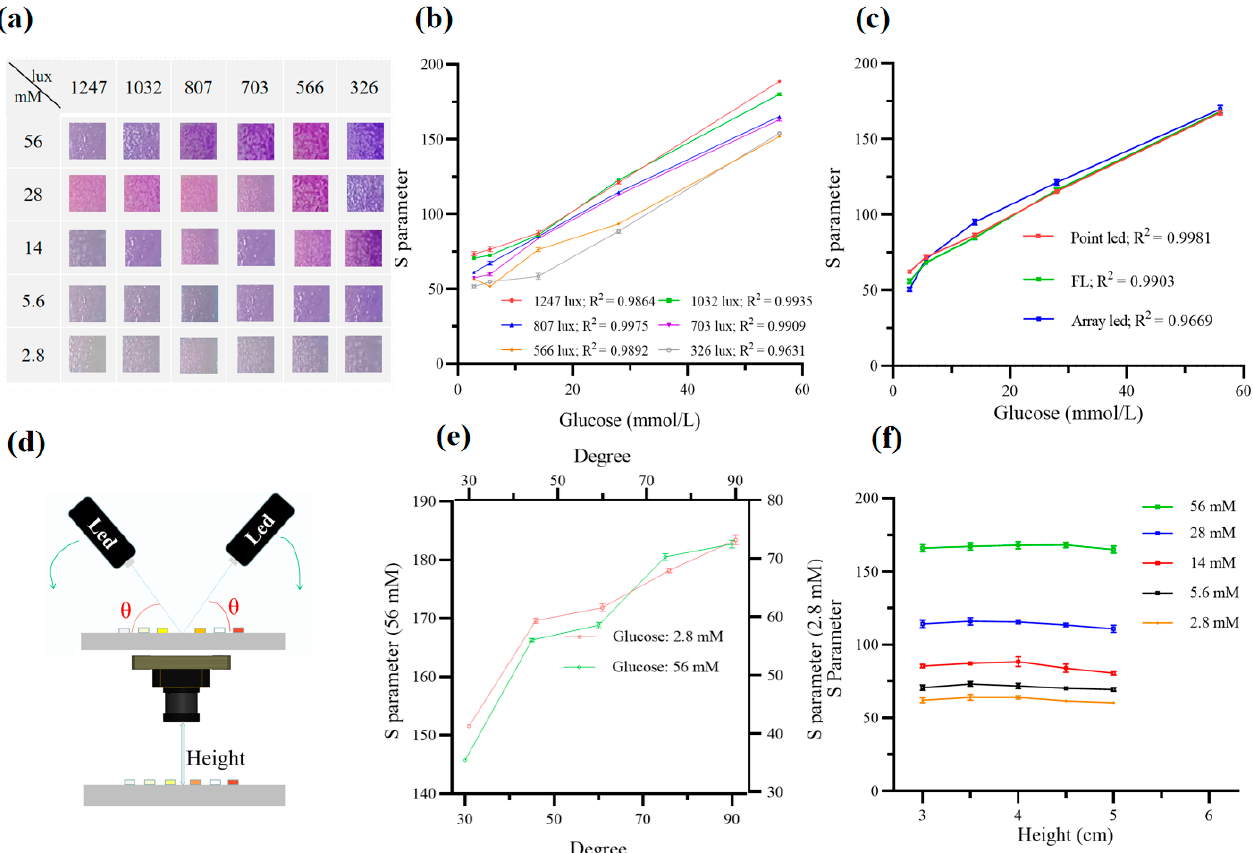
Figure 3. Optimization of the sensing conditions. Error bars show the standard derivation ( n = 3). ( a ) Glucose-dependent paper sensor images captured by the CSI camera with varying illuminance from LED. ( b ) S parameter vs. glucose plots measured at six different illuminances. ( c ) S parameter vs. glucose plots measured with different illumination conditions (FL, LED I-point light, LED II- array light). ( d ) Schematic illustrations showing different angles and heights for image capture. ( e ) S parameter vs. angle plots measured at glucose concentrations of 2.8 mM and 56 mM. ( f ) Comparison of S vs. glucose plots obtained from the images taken at varying distances from the sensor.